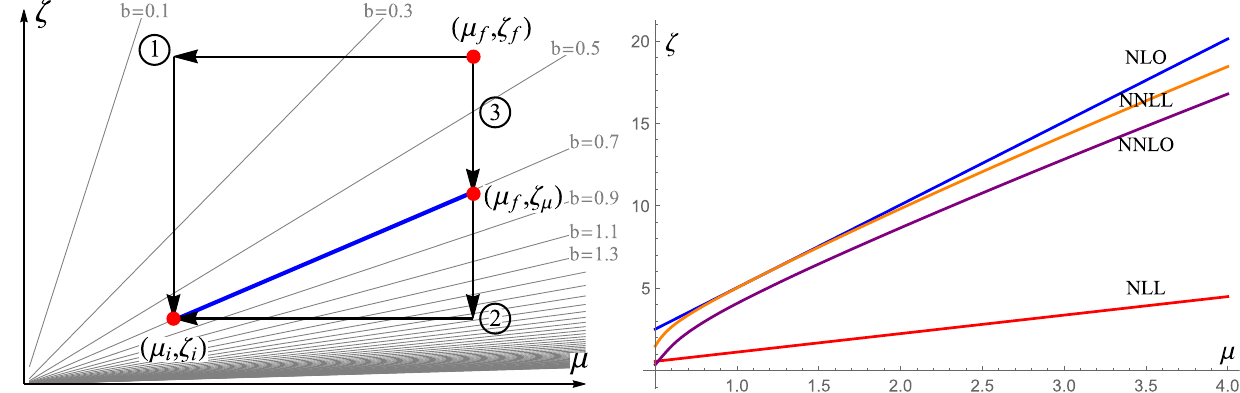
) ,whichisshownbypath3,becausethereisnoevolution point (μ f ,ζ μ f along the blue segment (at b = 0 . 7 GeV − 1 ). (right) The plot of ζ μ at b = 1 GeV − 1 for different orders